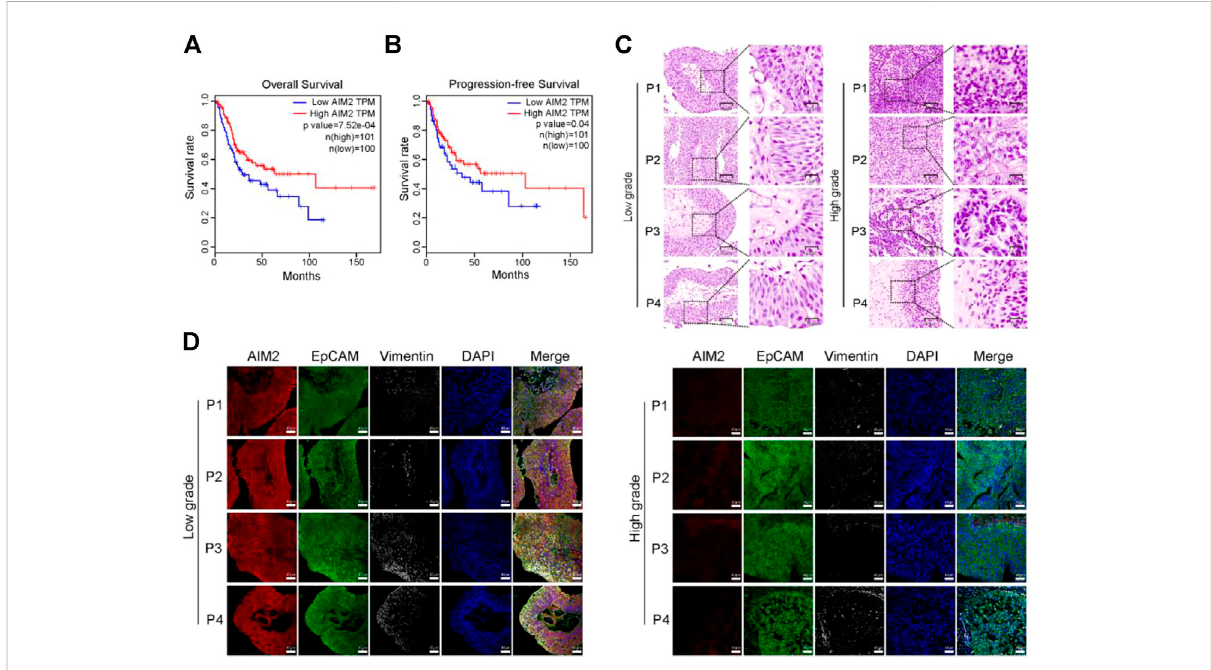
FIGURE 1 The innate immune sensor AIM2 expression level is positively correlated with the prognosis of BLCA patients. (A) Kaplan-Meier curves showing the overall survival (OS) time of patients with BLCA in the TCGA cohort. (B) Kaplan-Meier curves presenting the progression-free survival (PFS) of patients with BLCA in the TCGA cohort. (C) H and E staining of human high- and low-grade BLCA samples. (D) The protein level of AIM2, EpCAM (representing the epithelial component of bladder cancer), and Vimentin (the biomarker of the stromal component) by 4-color multiplex immuno fl uorescence (MIHC) staining assays. Survival rate (A,B) is compared by Log-Rank (Mantel-Cox)